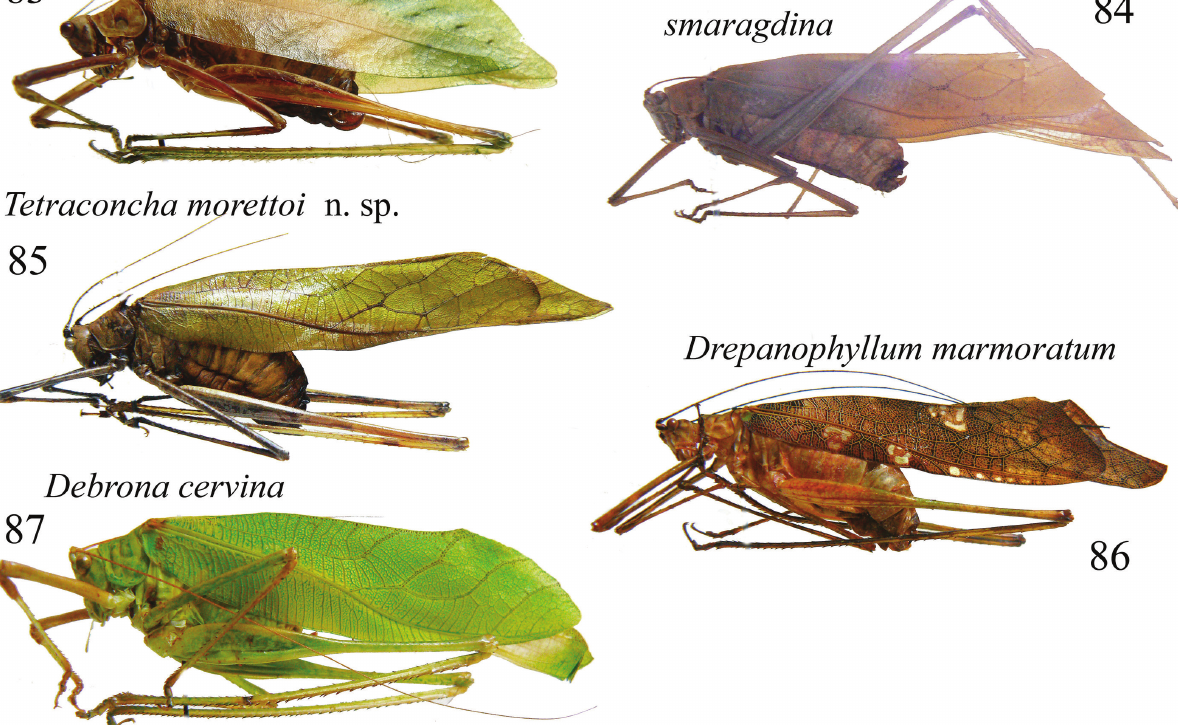
Figs 79–87. Left habitus in lateral view of females of: 79. Tetraconcha banzyvilliana ; 80. T. stichyrata ; 81. T. fenestrata ; 82. T. longipes ho- lotype female; 83. T. aristophanousi sp. n. paratype; 84. T. cf. smaragdina ; 85. T. morettoi sp. n. Paratype; 86. Drepanophyllum marmoratum ; 87. Debrona cervina